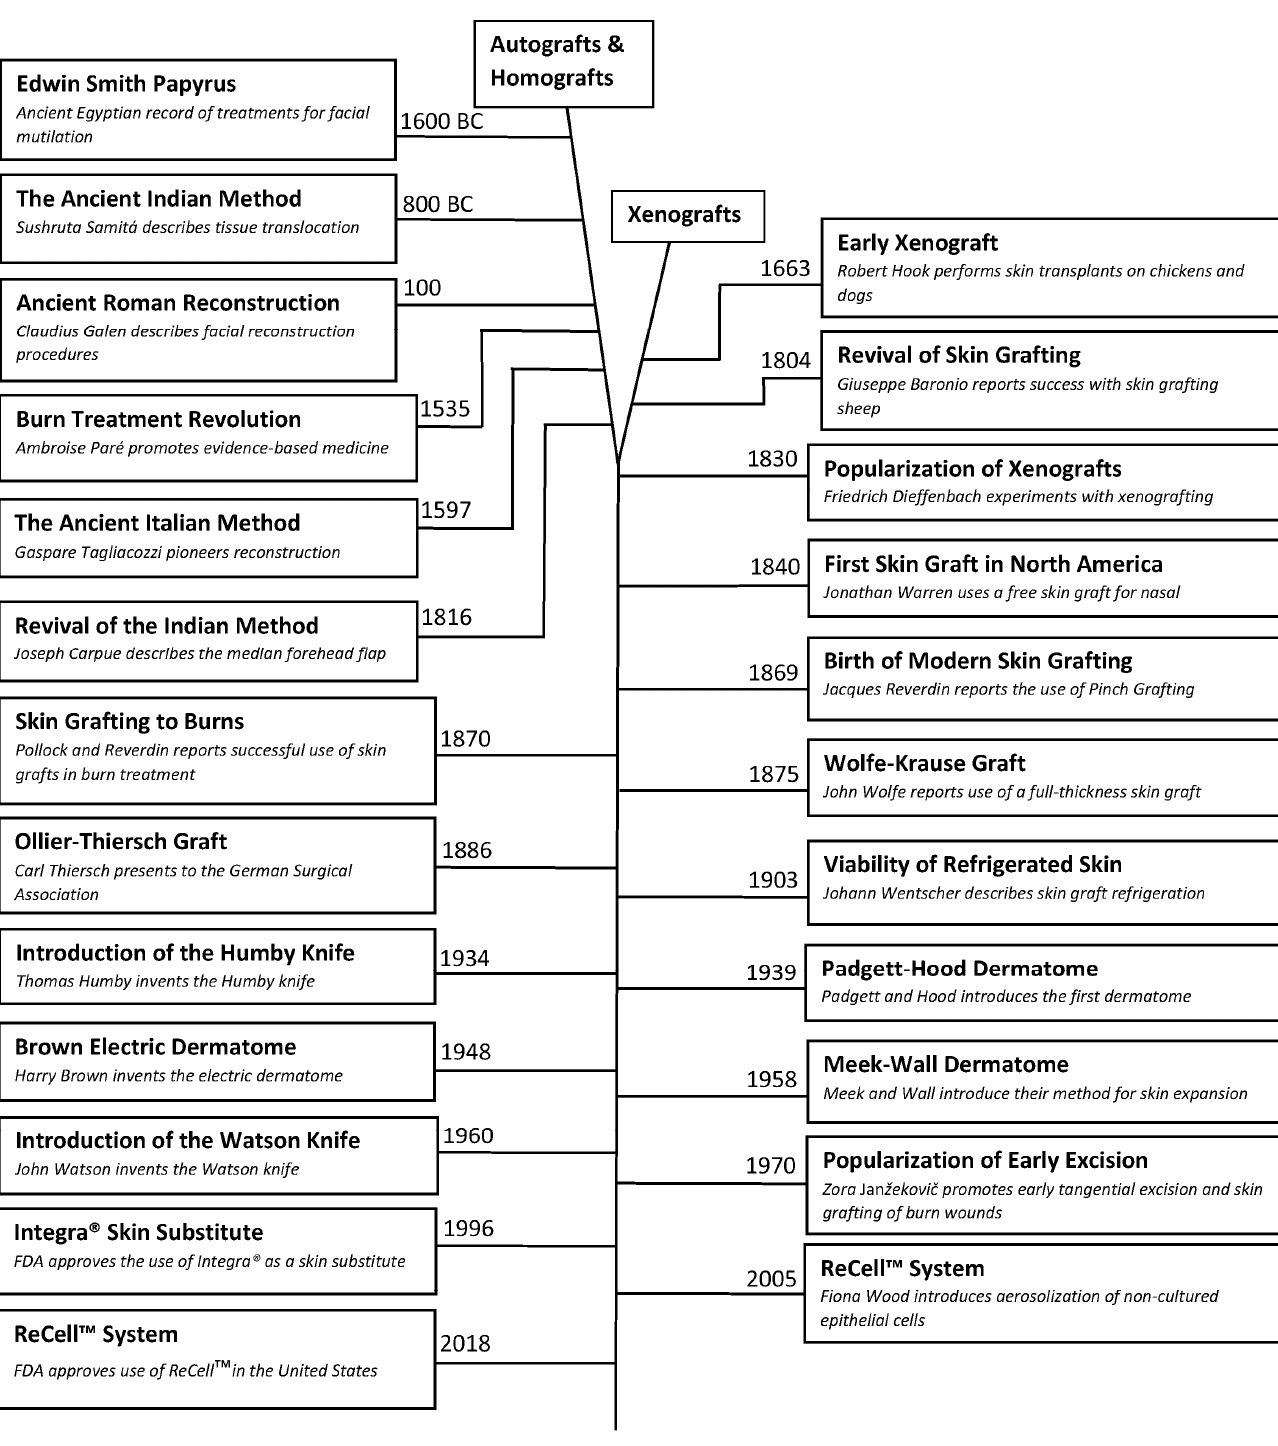
Figure 5. A timeline of the major historic events that preceded modern skin grafting in burn surgery.